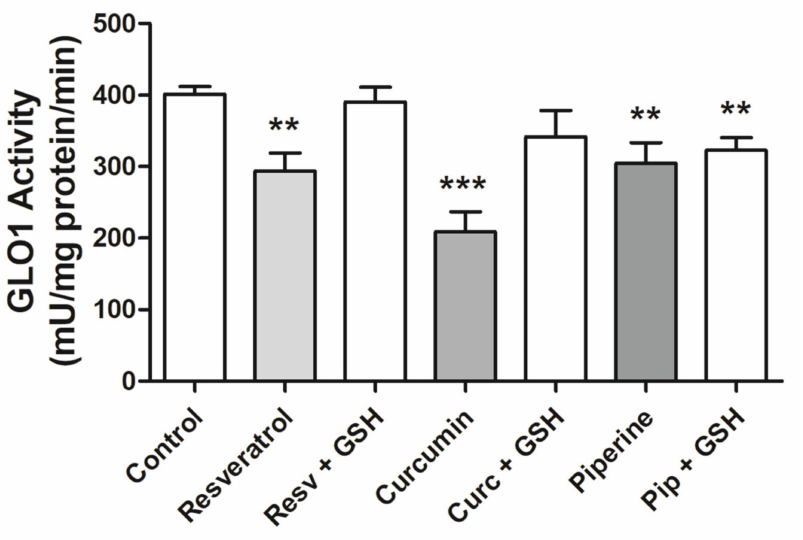
Figure 4. GLO1 activity in MCF-7 cells after resveratrol, curcumin and piperine treatment: Cells were treated with 100 µ M of GSH, and 131.0 µ M resveratrol, 24.5 µ M curcumin or 94.5 µ M piperine were added after 30 min. After 24 h, GLO1 activity was determined in lysed cell extracts. The results are representative of three experiments performed in triplicate ± SEM. ** p < 0.001 and *** p < 0.0001 in relation to the control. Resv = Resveratrol, Curc = Curcumin, PIP =